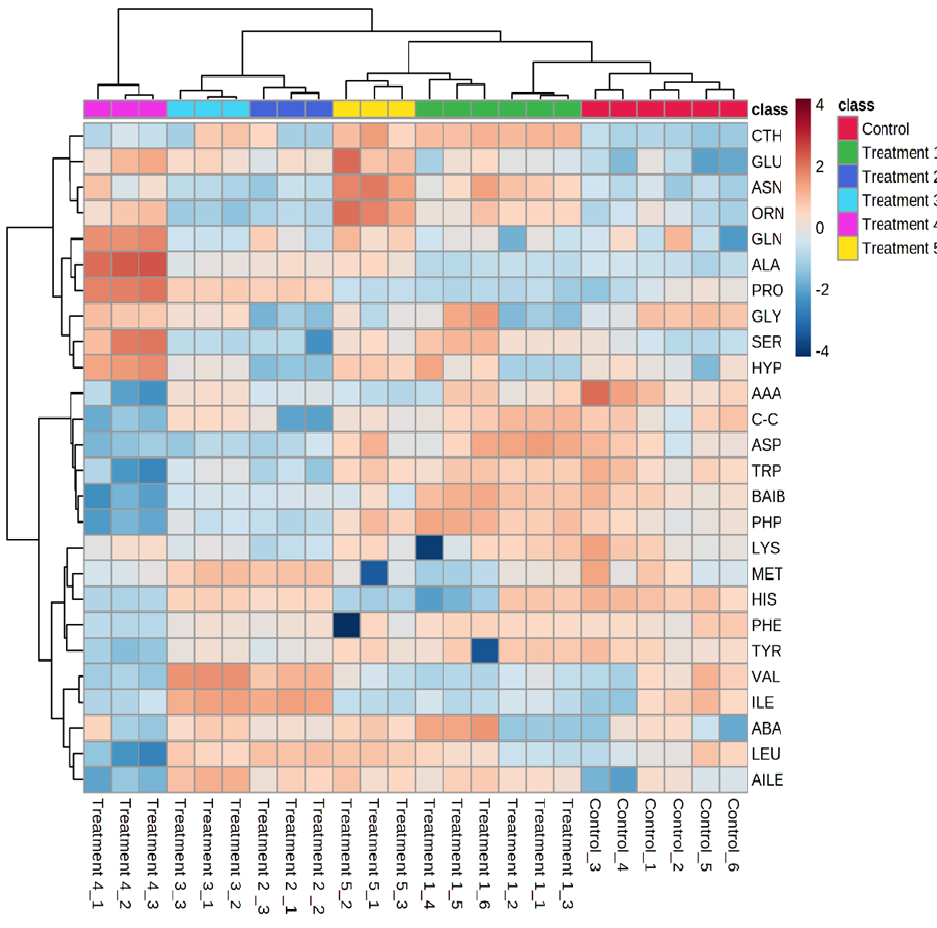
Figure 1. Heatmap exhibition of amino acid profiles from bacterial cells harvested at stationary phase from control and treatments samples (1 – 5). Each column denotes one biological sample; each row denotes one targeted amino acid. The colors represent relative amino acid abundance in each replicate.